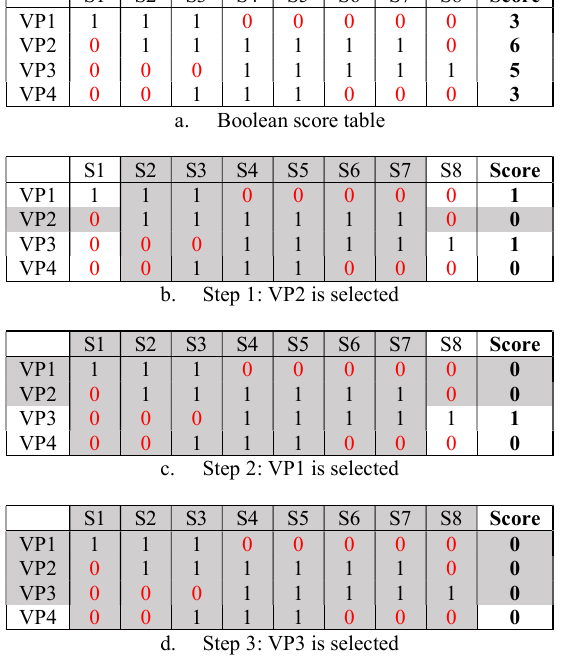
Table 1. Example 1: Greedy Algorithm